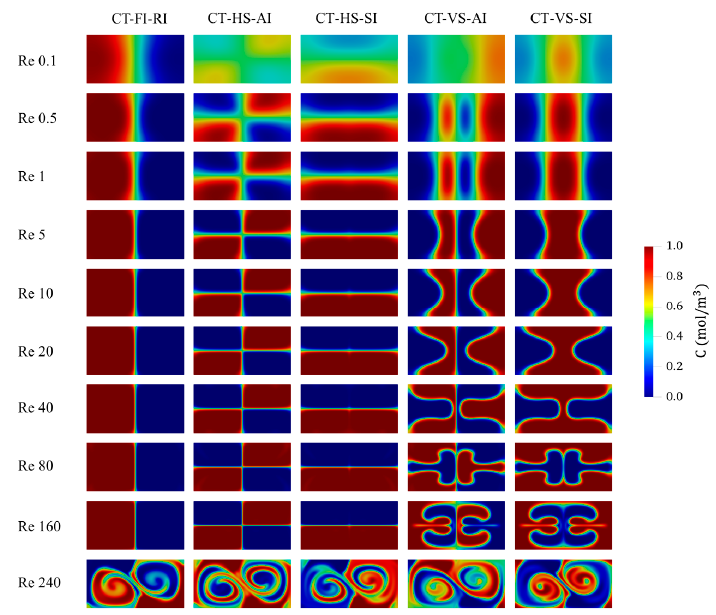
Figure 7. Outlet concentration distributions in CT micromixer configurations for D 1 = 3.0 × 10 − 10 m 2 / s molecular diffusion constant.